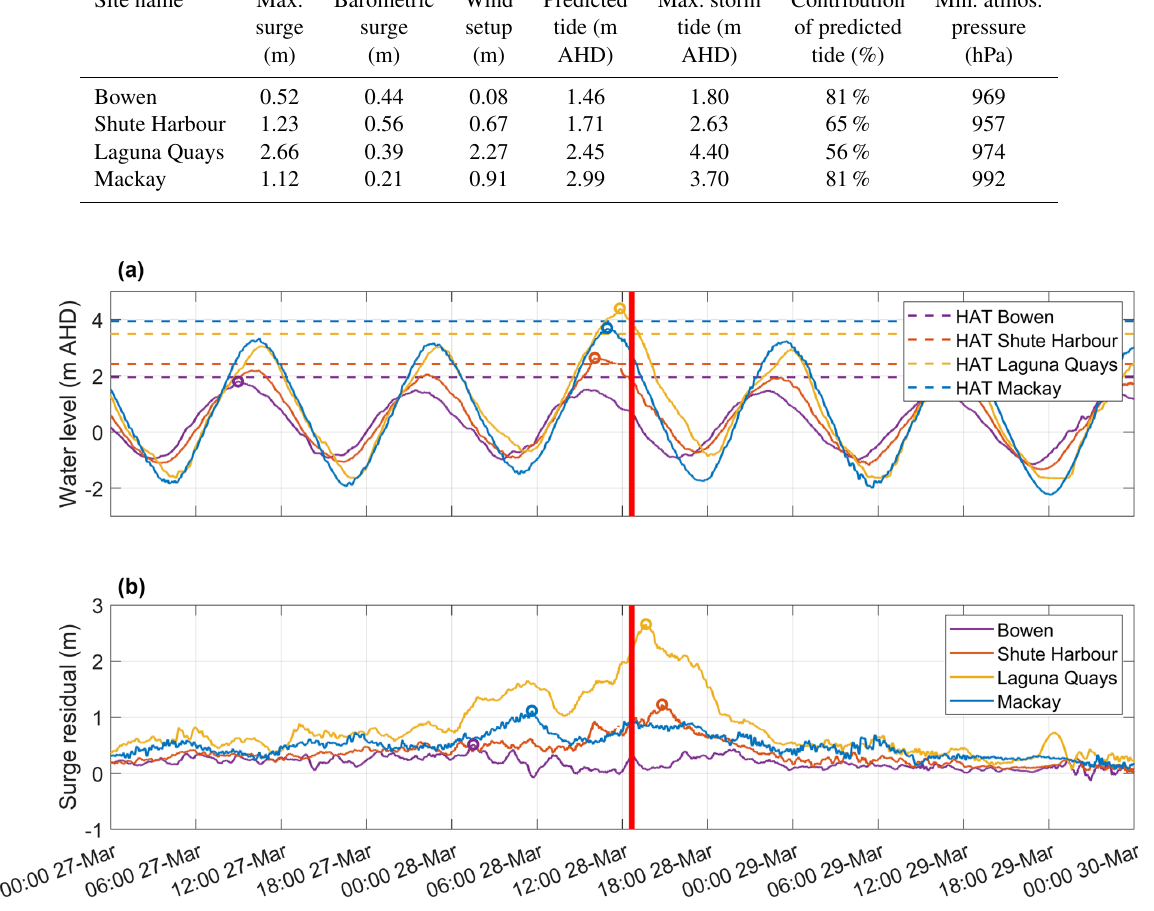
Figure 3. Water levels (a) and storm surge residuals (b) observed at (north to south) Bowen, Shute Harbour, Laguna Quays and Mackay storm tide gauges during TC Debbie . Highest Astronomical Tide (HAT, dotted horizontal lines), times of maximum water level (circles in a ) and times of maximum surge residuals (circles in b ) are also shown. Red vertical line indicates approximate time of landfall at Airlie Beach. Time is in Australian Eastern Standard Time (AEST, UTC + 10h). Track of Debbie during this period (up to landfall) can be seen in Fig.